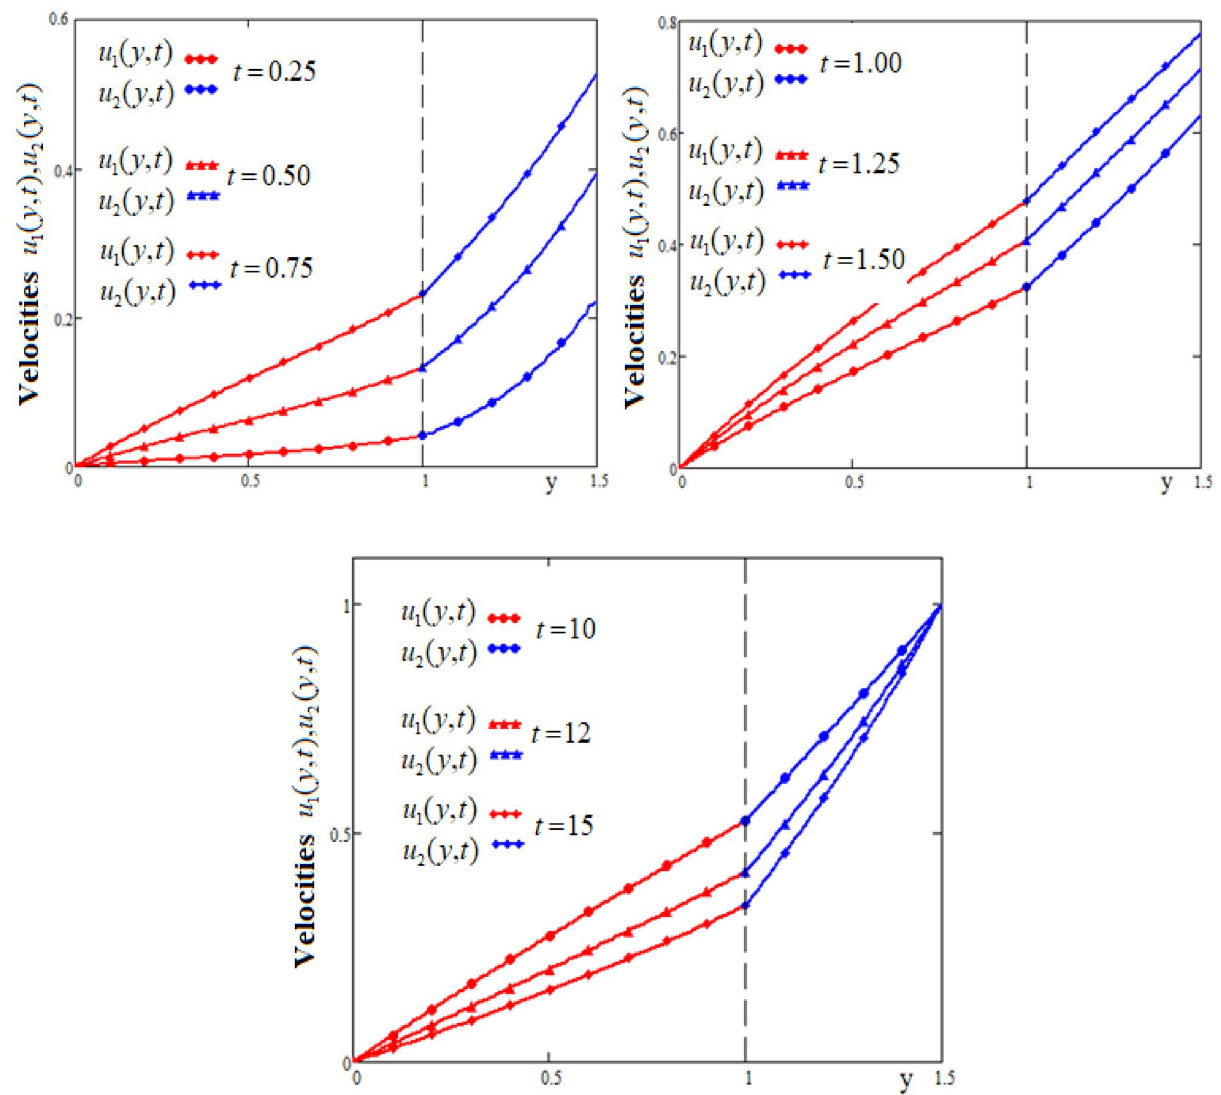
Figure 2. The profiles of velocities u 1 ( y , t ) , u 2 ( y , t ) versus y for different values of the time t.